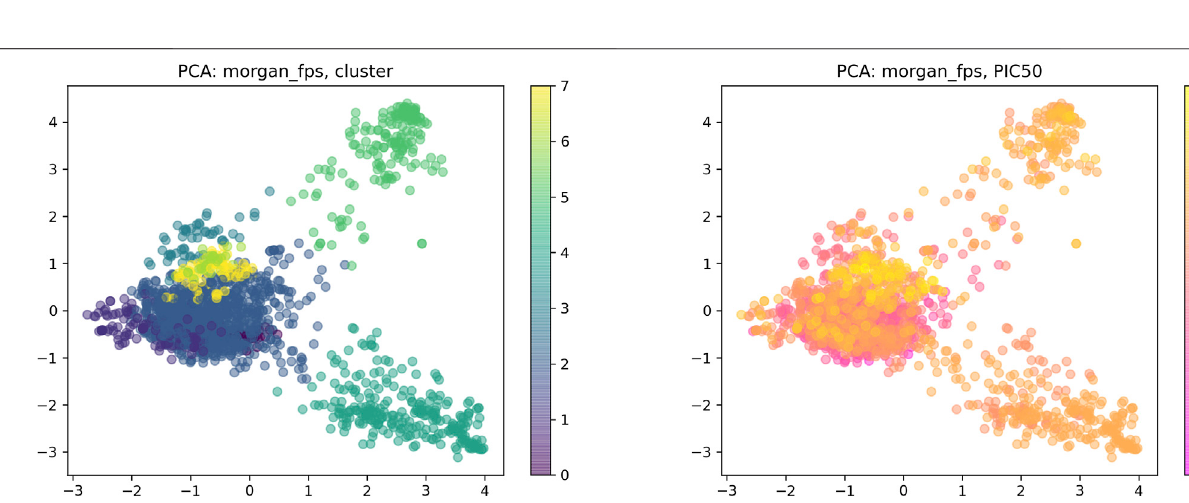
FIGURE 3 | Design of the 1,2,3-triazole series compounds based on erlotinib.